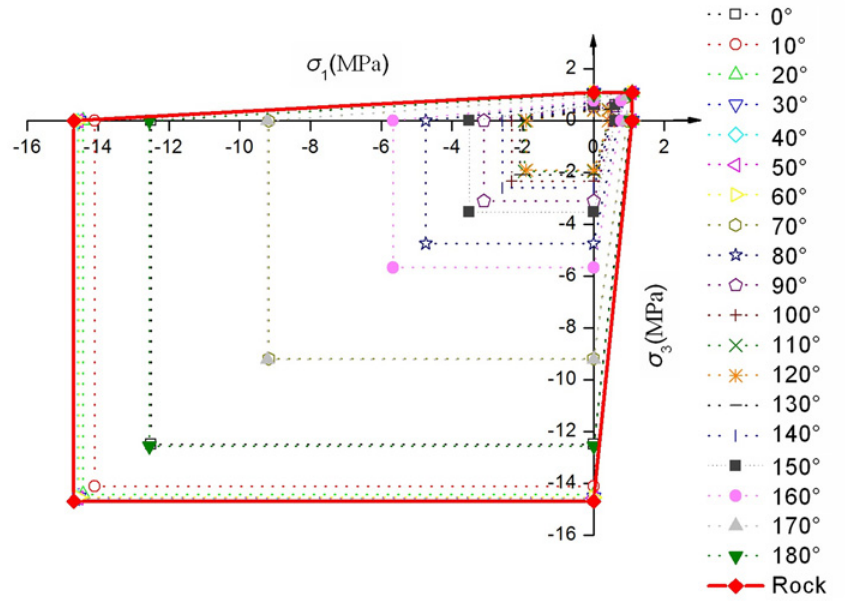
Fig 6. The relation between strength in σ 1 - σ 3 plane and the visual angle β